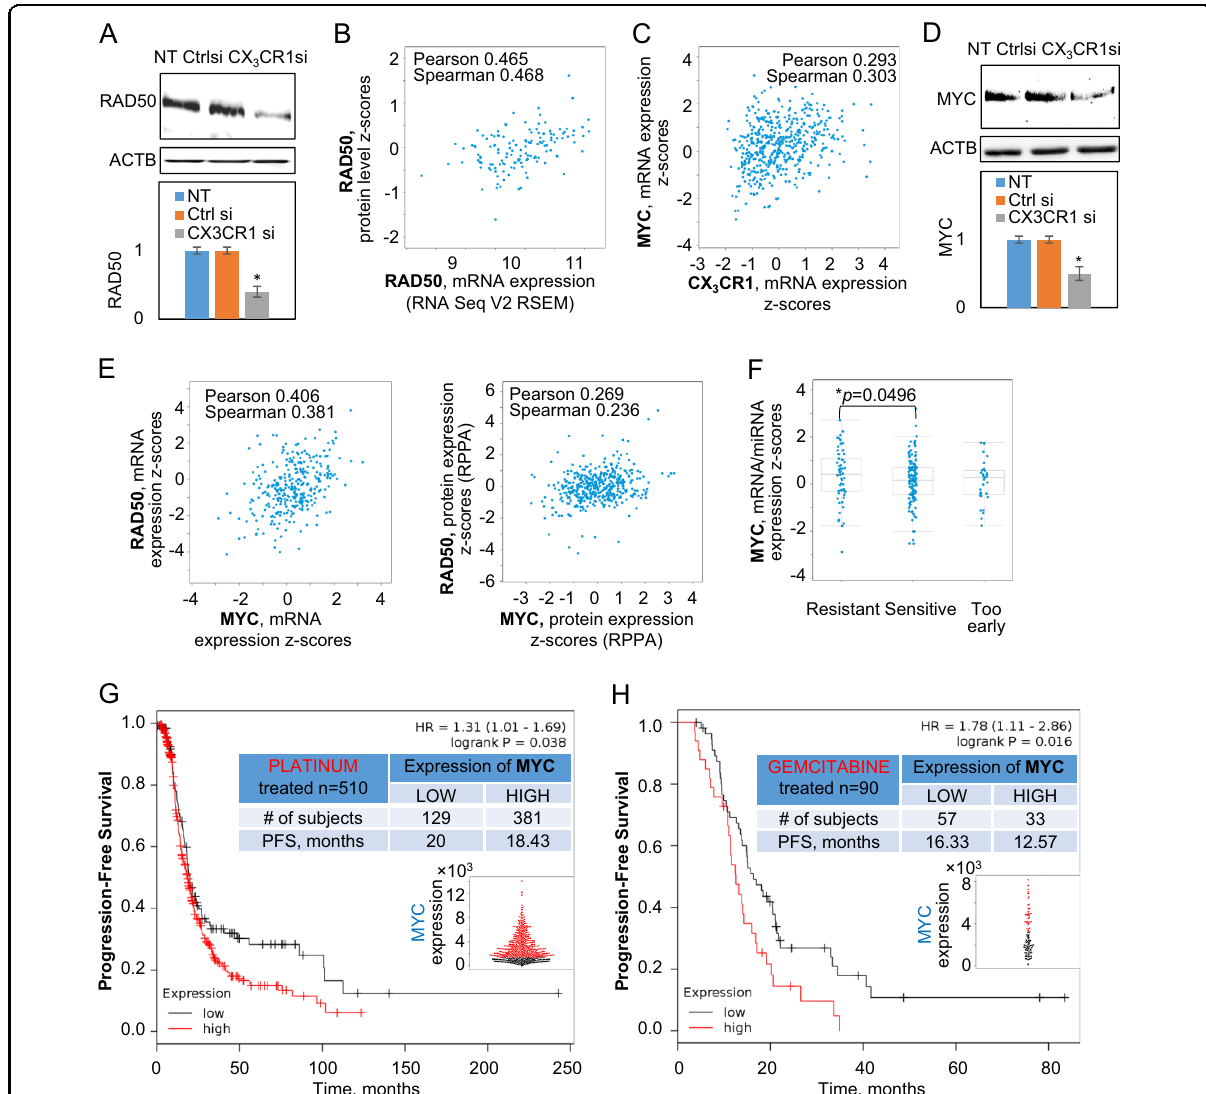
Fig. 5 CX 3 CR1 regulates expression of RAD50 and MYC in HGSOC cells. Expression of RAD50 ( a ) and MYC ( d ) in OVCAR-4 transiently transfected with either CX 3 CR1-speci fi c (CX 3 CR1si) or control (CTRLsi) siRNAs or transfected with vehicle (NT) was determined using western blot. ACTB were used as a loading control. Images were quanti fi ed with digital densitometry using BIO-RAD Chemidoc software, the results of three independent experiments were averaged and plotted. * p < 0.05, Student ’ s t test. Correlation between expression of RAD50 mRNA and protein ( b ) as well as CX 3 CR1 mRNA and MYC mRNA ( c ) were examined using gene expression data from cBioportal database for serous ovarian cystadenocarcinoma (TCGA, Provisional, n = 603); correlation coef fi cients are indicated on the charts. e Correlation between expression of MYC mRNA and protein as well as RAD50 mRNA and protein in specimens of serous ovarian adenocarcinoma were analyzed using cBioportal database and TCGA, Provisional, dataset ( n = 603); correlation coef fi cients are indicated on the graphs. f Correlation between MYC mRNA expression and platinum response status (resistant, sensitive, too early) in serous cystadenocarcinoma specimens was examined using cBioportal database and TCGA, Nature 2011, dataset ( n = 557); the data were statistically analyzed using the Mann – Whitney U test. OS and PFS of serous ovarian carcinoma patients treated with platinum therapies ( g ) and gemcitabine ( h ) as a function of MYC expression were analyzed using KM Plotter database. Red lines — high MYC, black lines — low MYC. Numbers of specimens with high (red) and low (black) MYC for each analyzed group and their corresponding average survival are shown in the tables. The best performing threshold was used to determine MYC-low and MYC-high groups of specimens using KM Plotter software. Expression of MYC in examined specimens is plotted as beeswarm plots shown as inserts; red — high MYC, black — low MYC. Survival was analyzed with Mantel − Cox log-rank test using KM Plotter software; hazard ratios (HR) p values are indicated on the